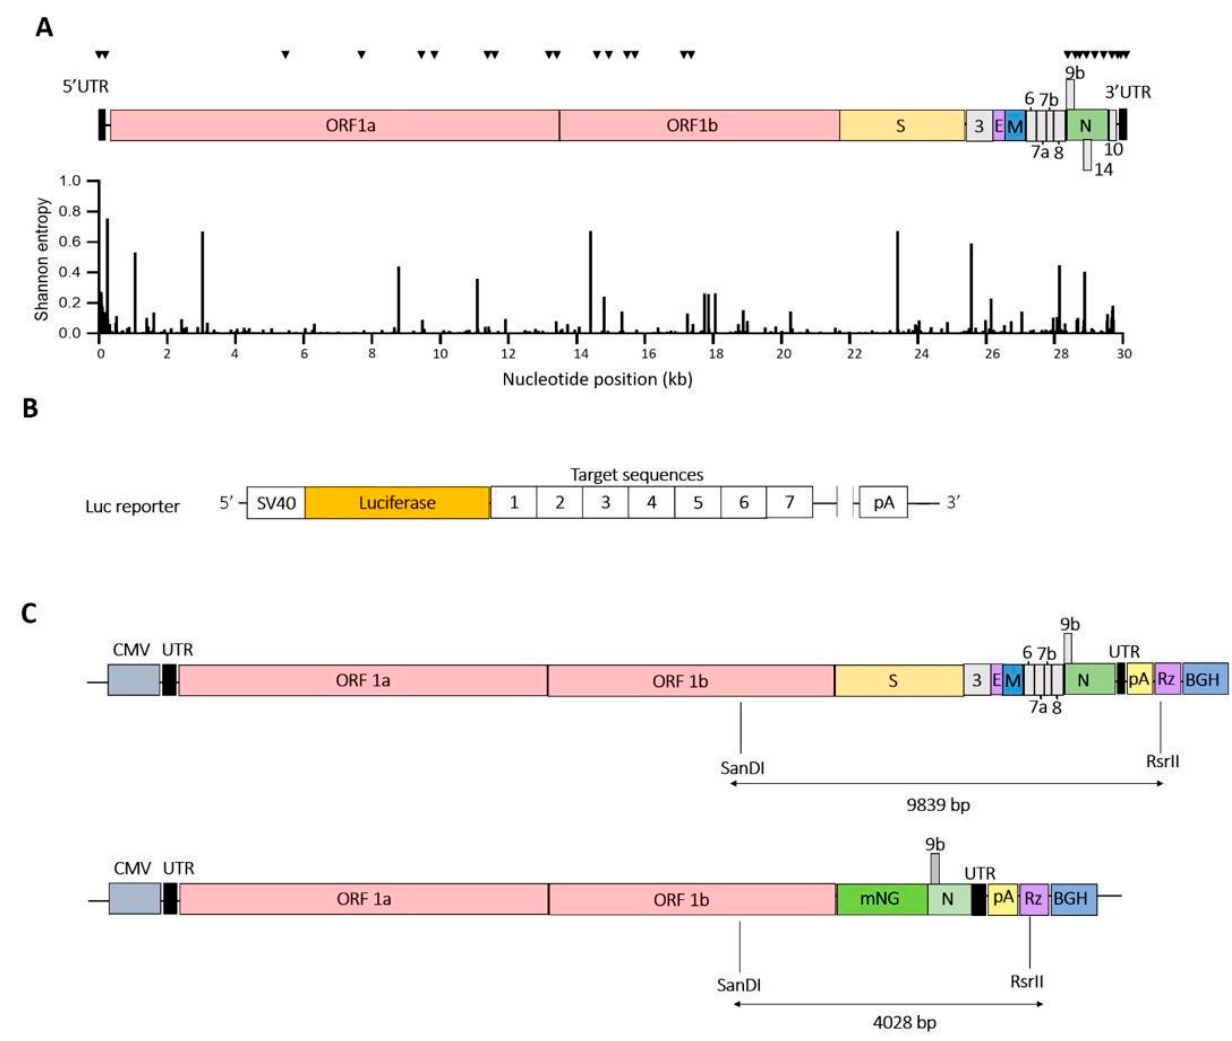
Figure 2. Targeting of SARS-CoV-2 RNA with CRISPR/Cas13d. ( A ) SARS-CoV-2 RNA genome diversity and the crRNA targets. Distribution of crRNAs along the SARS-CoV-2 RNA genome (MN908947). The Shannon entropy along the RNA genome varies from 0 to 1, where lower genetic diversity gives values closer to zero.The position of the crRNAs targeting conserved RNA sequences of SARS-CoV-2 is indicated with black triangles. The SARS-CoV-2 RNA genome diversity is shown by plotting Shannon entropy along the whole genome. The values vary between 0 and 1, where more conserved sequences give lower values (closer to 0); ( B ) Luciferase multitarget reporter construct. To measure the efficiency of the designed crRNAs, a pGL3 control plasmid-based multi- target luciferase reporter construct was designed with SARS-CoV-2 conserved target sequences cloned downstream of the firefly luciferase gene. Two constructs were designed: one with the + and one with the − RNA target sequences. SV40: simian virus 40 promoter, pA, polyA sequence; ( C ) Engineering a SARS-CoV-2 replicon. Scheme of the SARS-CoV-2 cDNA cloned in a BAC (upper panel) and the SARS-CoV-2 replicon (lower panel). The letters indicate the viral genes: S, spike; E, envelope; M, membrane; N, nucleocapsid; or the reporter gene mNeonGreen (mNG). UTR, untranslated regions; CMV, cytomegalovirus promoter; pA, polyA sequence; Rz, hepatitis delta virus ribozyme; BGH, bovine growth hormone polyadenylation and termination signals. Table 1. crRNAs targeting SARS-CoV-2 RNA. Name